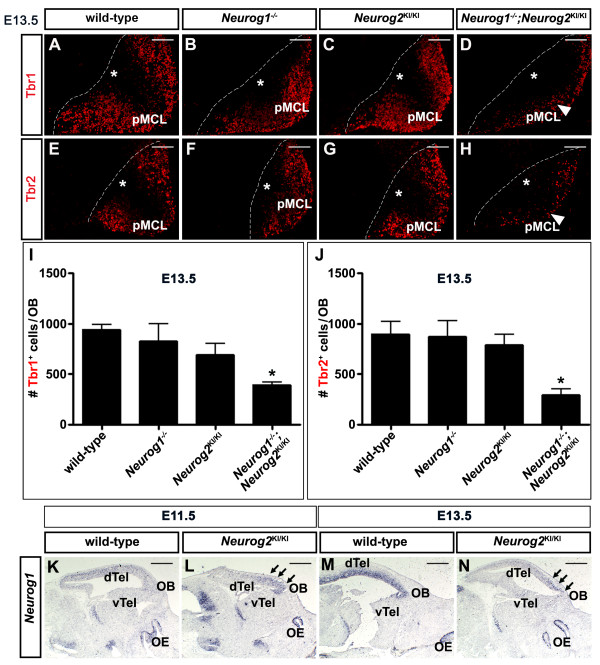
Defects in the differentiation of glutamatergic olfactory bulb neurons inNeurog1/2 double mutants. (A) to (H) Expression of Tbr1 (A) to (D) and Tbr2 (E) to (H) in the presumptive MCL of embryonic day (E) 13.5 wild-type (A,E), Neurog1−/− (B,F), Neurog2 KI/KI (C,G) and Neurog1/2 −/− (D,H) OBs. White arrowheads in D,H mark the reduction in glutamatergic neurons in Neurog1/2−/− OBs. White asterisks in (A) to (H) mark the ventricular zone. (I), (J) Quantitation of total numbers of Tbr1+ cells (I) and Tbr2+ cells (J) in E13.5 wild-type Neurog1−/−, Neurog2KI/KI and Neurog1/2−/− OBs. Asterisks denote P <0.05. (K) to (N) Analysis of Neurog1 expression in E11.5 (K,L) and E13.5 (M,N) wild-type and Neurog2−/− telencephalons. Arrows mark ectopic Neurog1 expression in (L) and (N). Scale bars: 250 μm (A) to (H), 1 mm (K) to (N).